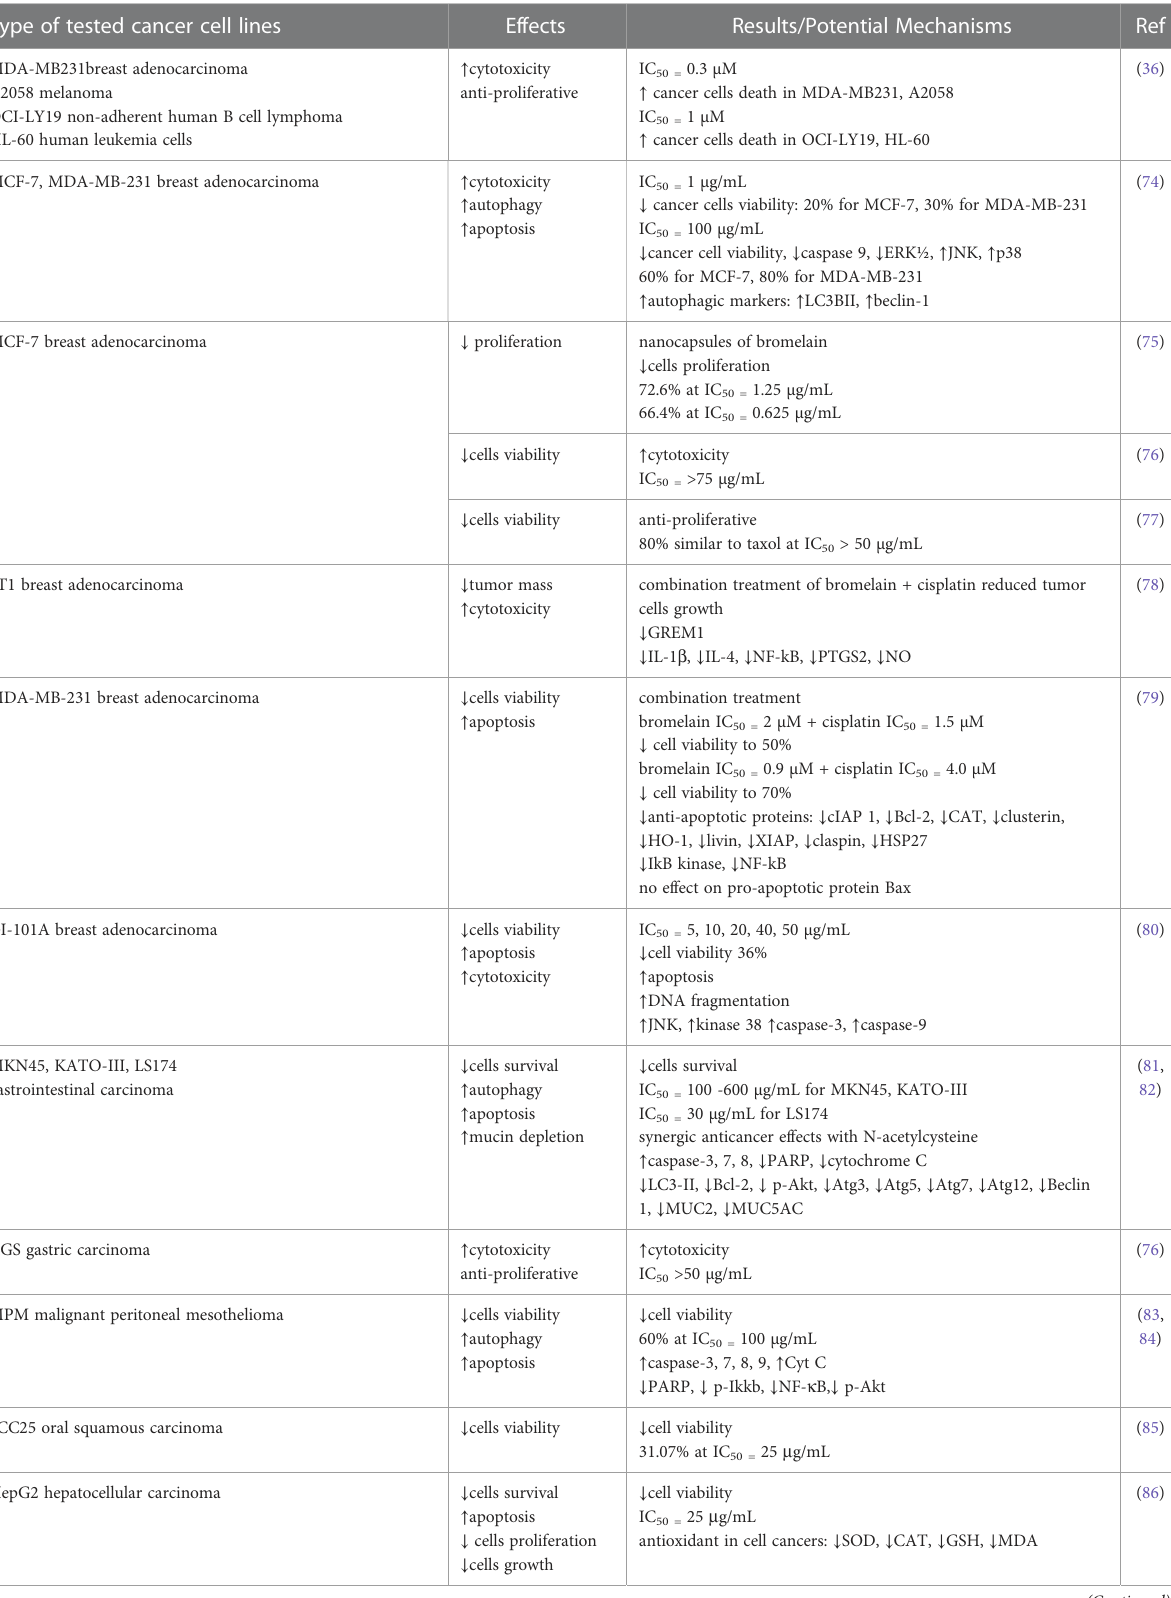
TABLE 2 Table with summarized anticancer mechanisms of Bromelain from in vitro studies. Type of tested cancer cell